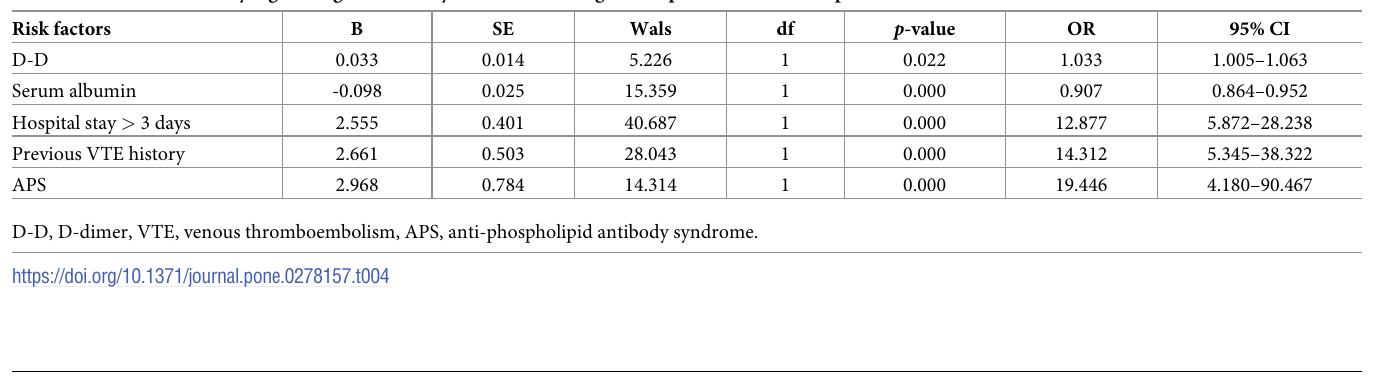
The efficacy of the independent risk factor-combined prediction model for predicting the risk of VTE was better than that of the Padua scale ( Z = 3.774, p < 0.001) and the Padua-combined prediction model ( Z = 1.999, p = 0.045), as shown in Fig 2.